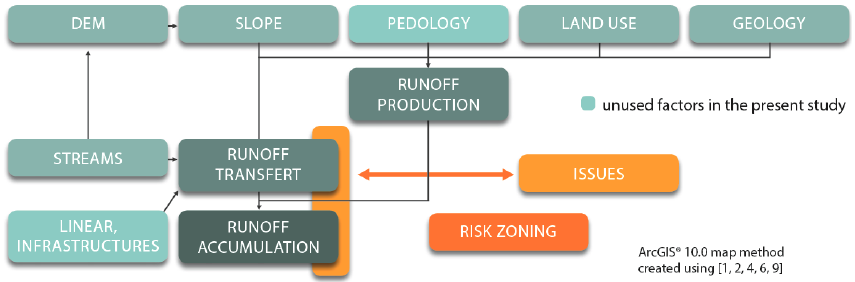
Figure 2. The MARE methodology. References [2]: Estupina Borrell (2004); [4]: Dehotin and Breil (2011); [6]: Macary et al. (2014); [9]: Verro et al. (2002).